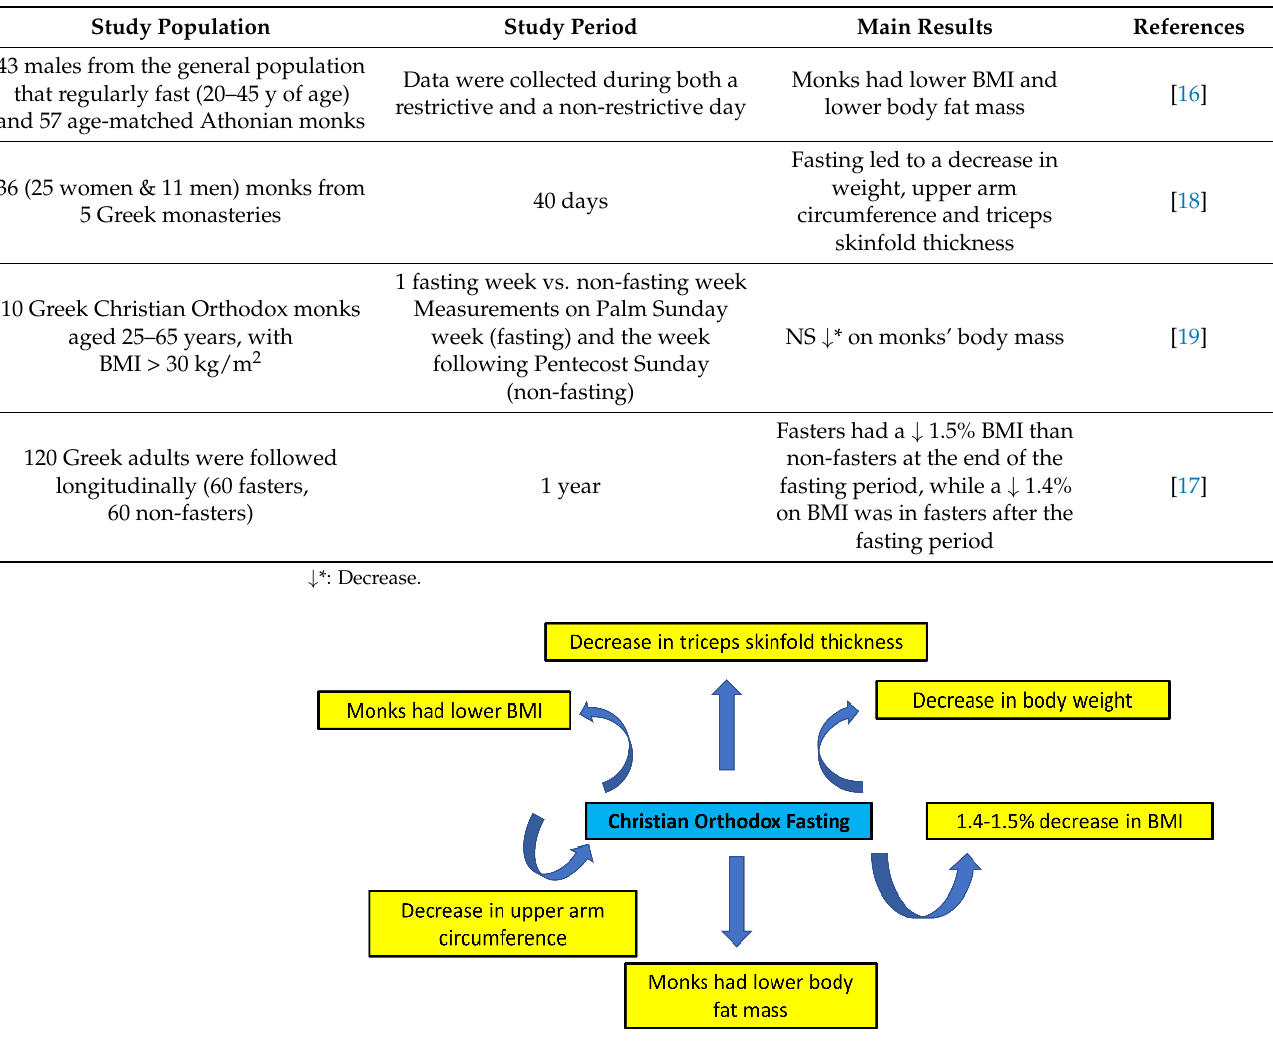
Table 2. Studies concerning the impact of Christian Orthodox fasting on weight control.